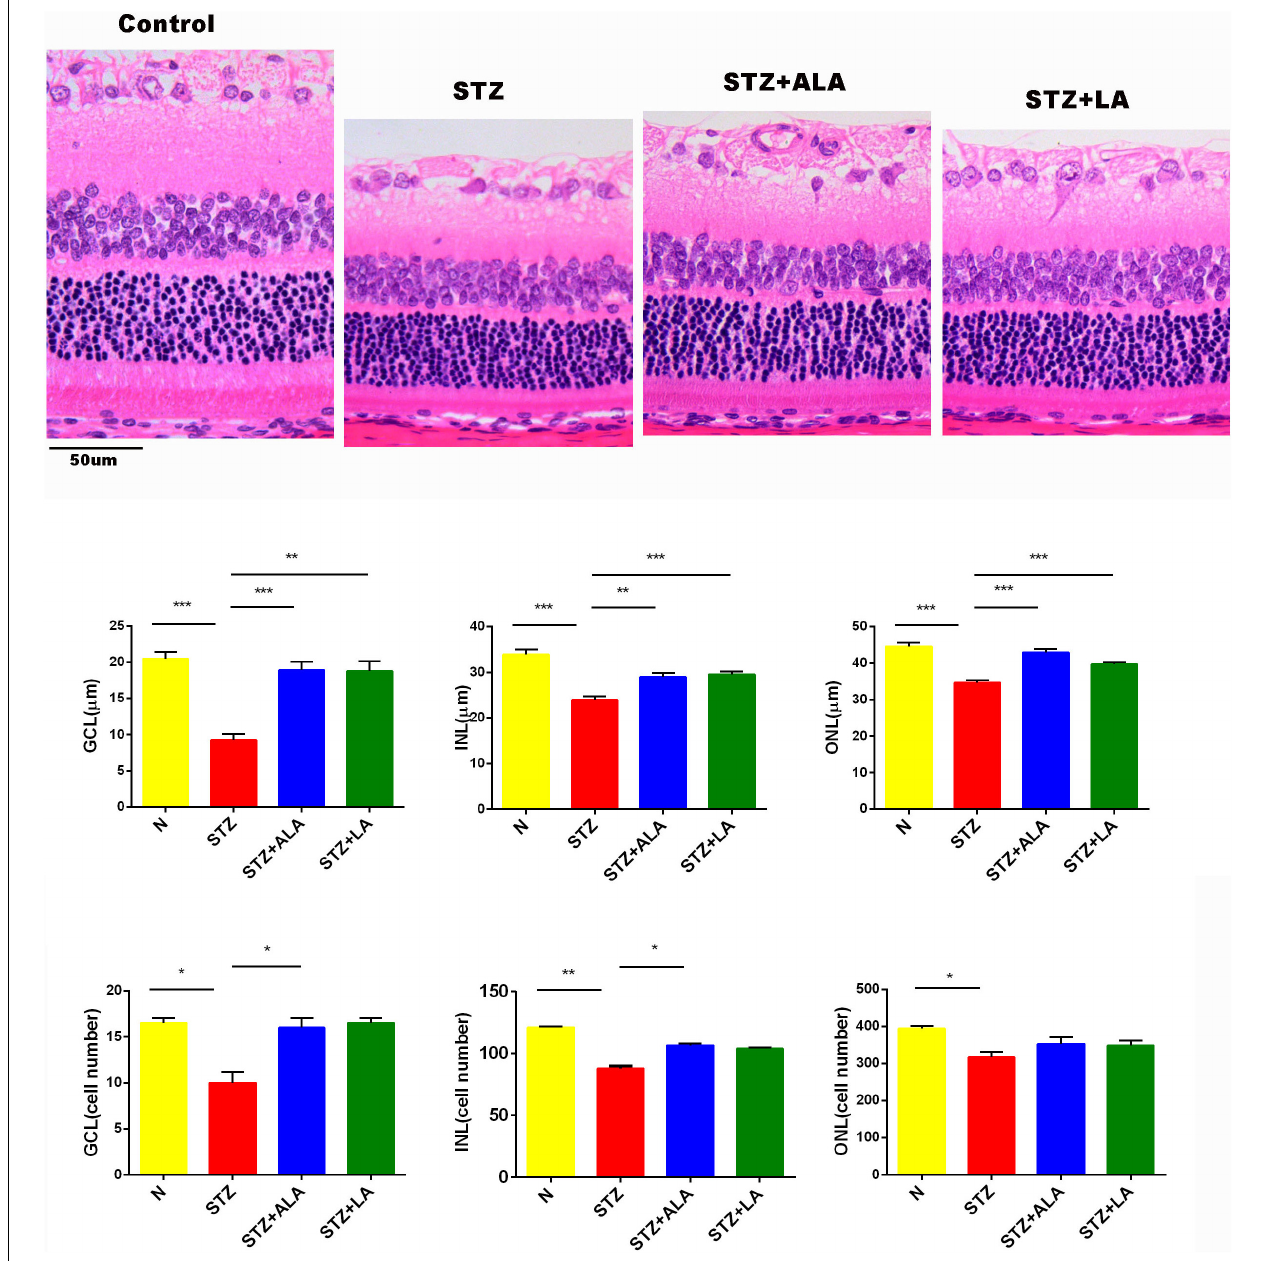
FIGURE 3 | The thickness and the cell number of the retina were measured on HE-stained samples. Magnification, X200. All values are expressed as mean ± SEM ( n = 5). Comparisons were performed using one-way ANOVA with Tukey’s post-hoc test. * vs. the STZ-treated group. * p ≤ 0.05, ** p ≤ 0.01, *** p ≤ 0.001. to those with diabetes mellitus for decreasing the severity of hyperglycemia and lipid